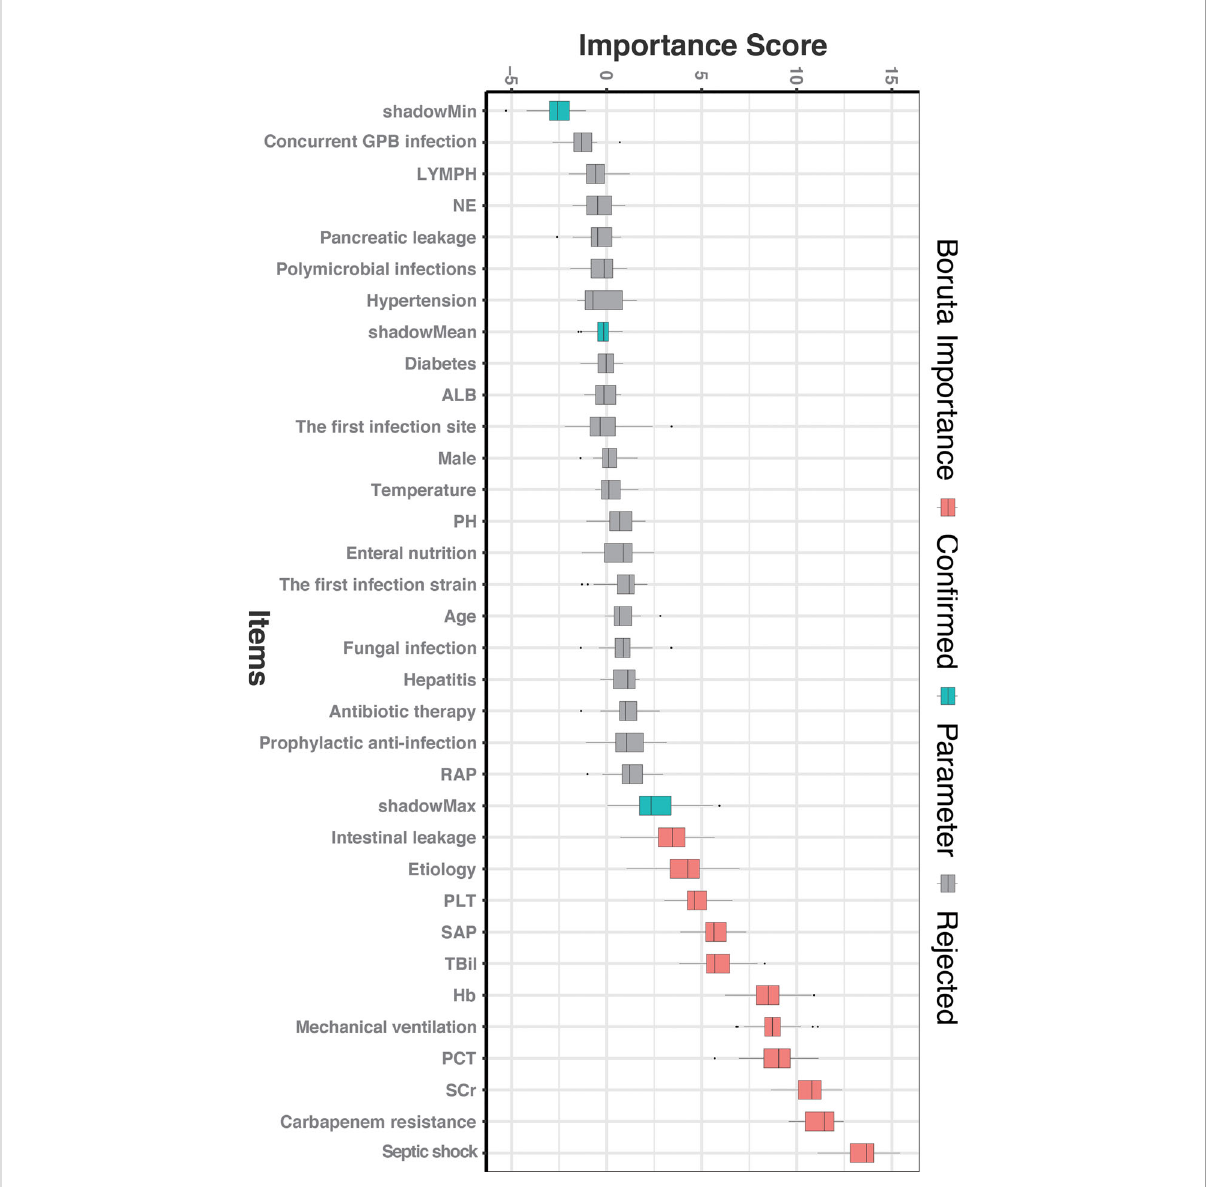
FIGURE 1 The feature importance in the Boruta feature selection process. The red box represents the feature that is con fi rmed as important, the green box represents the Boruta parameter, and the gray box represents the feature that is rejected. SCr, serum creatinine; PCT, procalcitonin; Hb, hemoglobin; TBil, total bilirubin; SAP, severe acute pancreatitis; PLT, platelet; RAP, recurrent acute pancreatitis; PH, potential of hydrogen; ALB, albumin; NE, neutrophilic granulocyte; LYMPH, lymphocyte; Concurrent GPB infection, Concurrent Gram-positive bacterial